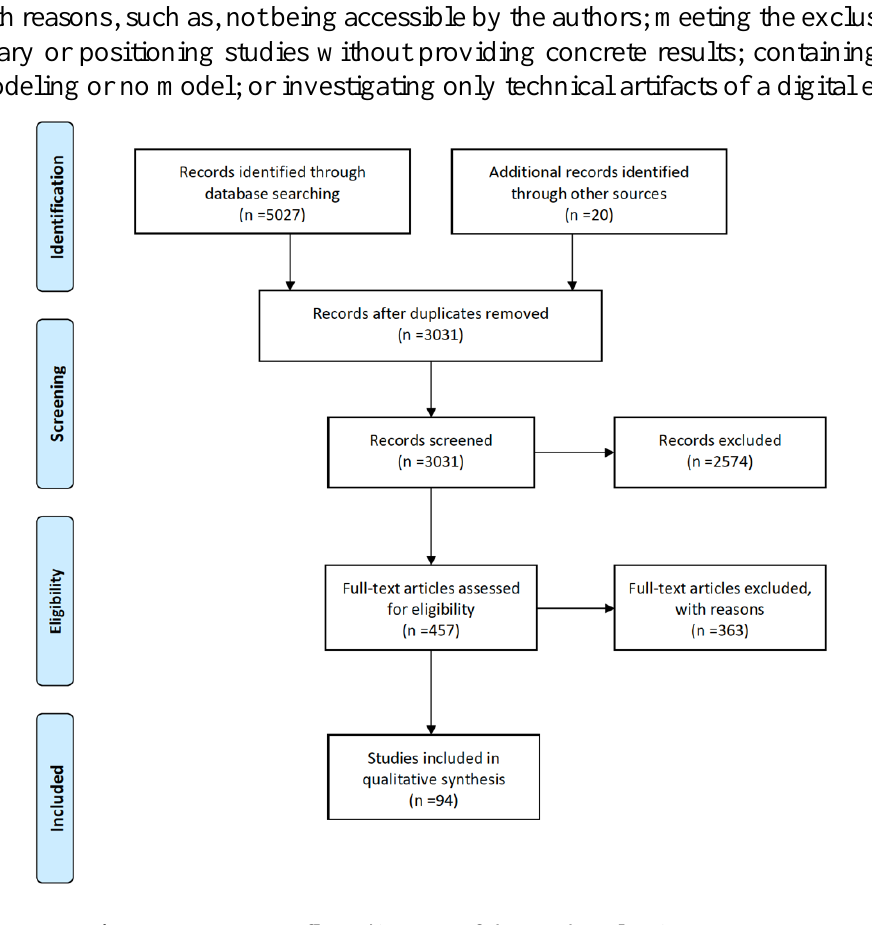
Figure 1. PRISMA flow diagram of the study selection